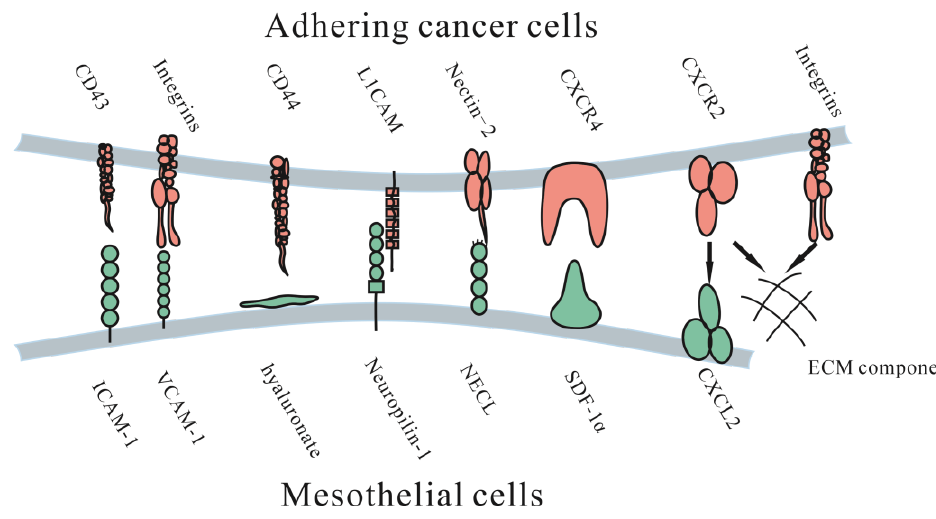
Figure 2. Molecular mechanisms of adhesive interactions mediating peritoneal carcinomatosis. ICAM-1 = intercellular adhesion molecule-1. VCAM-1= vascular cell adhesion molecule-1. L1CAM = L1 cell adhesion molecule. NECL = Nectin-like (NECL) family. CD44 = hyalonurate receptor. SDF-1 α = stromal cell-derived factor 1 α . CXCR4 = CXC receptor 4. CXCR2 = CXC receptor 2. CXCL12 = CXC ligand